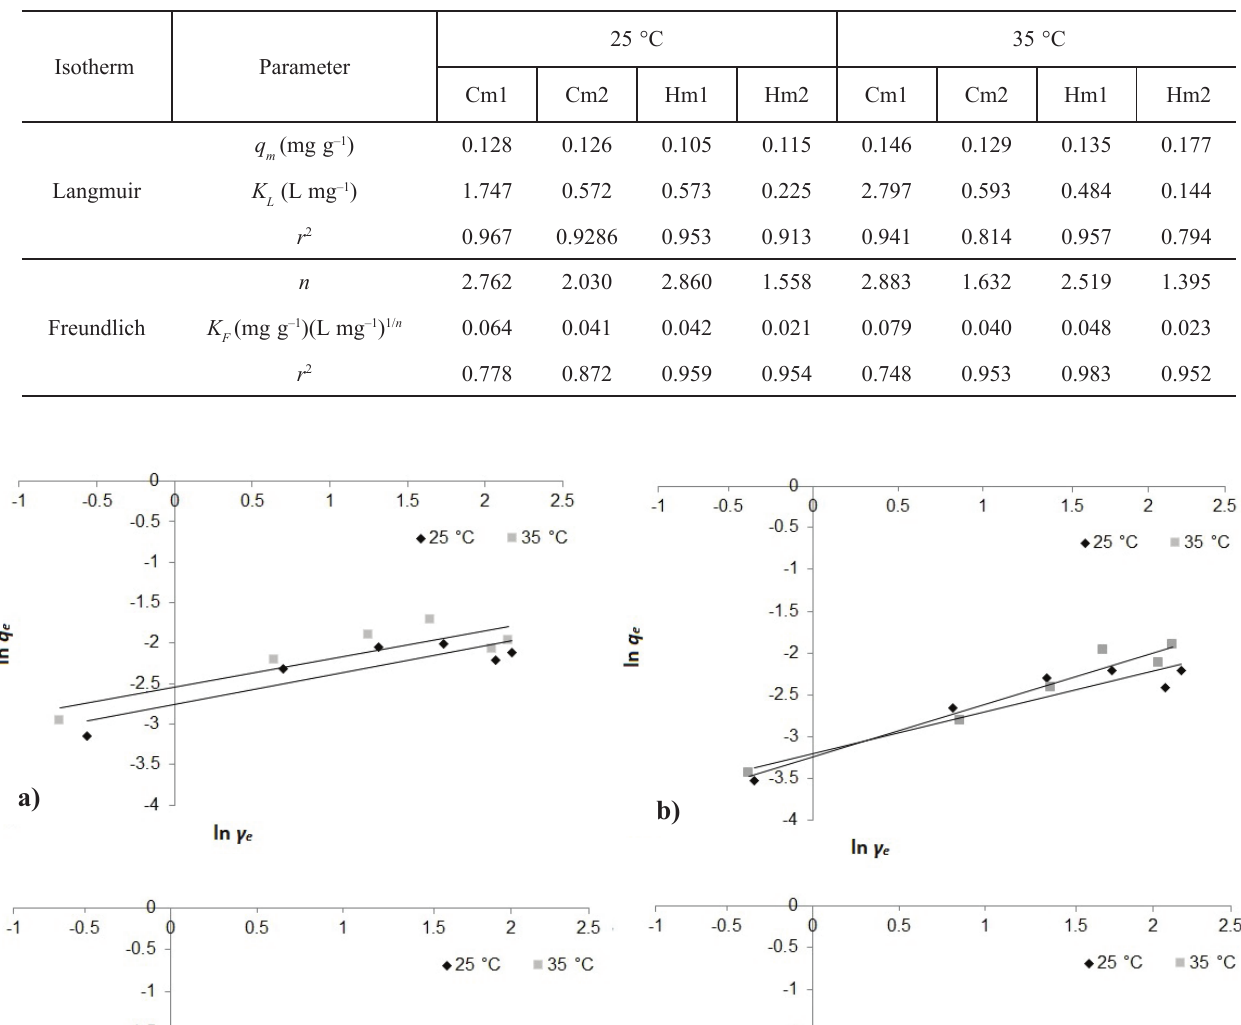
Table 2 – Langmuir and Freundlich isotherm models for HA adsorption by tested modified activated carbons